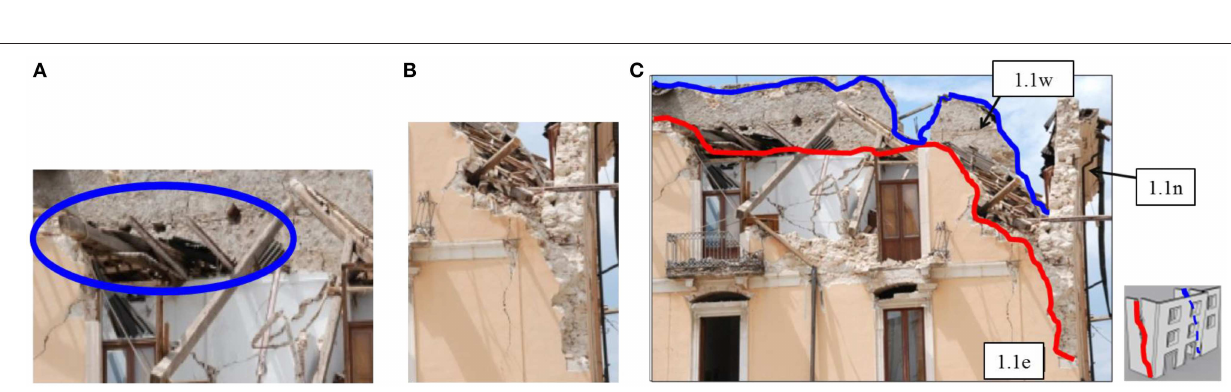
Frontiers in Built Environment |